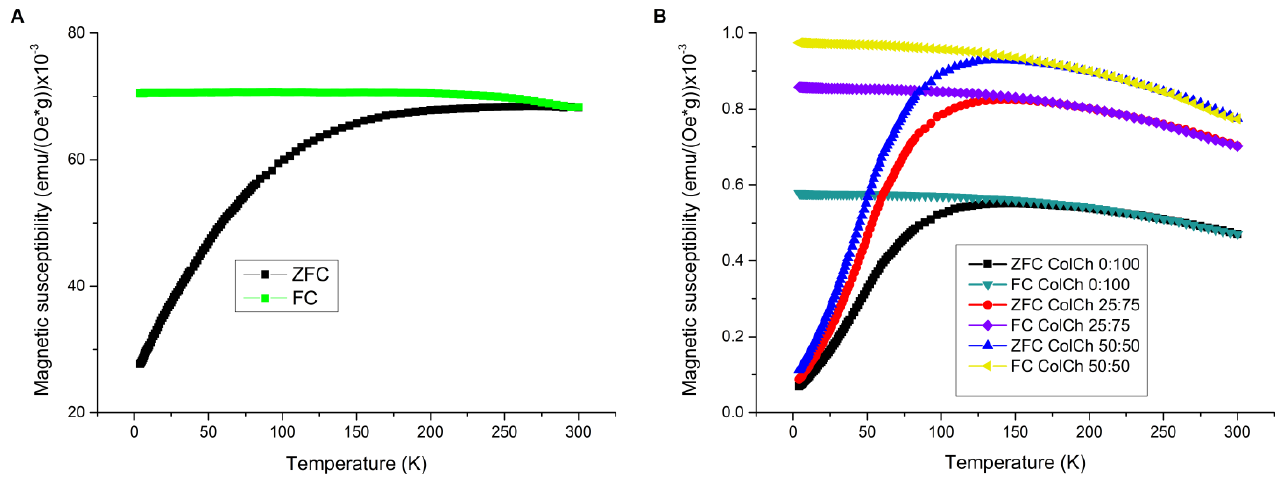
Figure 5. ZFC/FC curves measured for SPIONs ( A ) and hybrids ( B ). When comparing the obtained values of magnetic susceptibility for SPIONs and hybrids, a difference of two orders of magnitude could be observed. This was in line with the above discussed concentration issues and the resultant interparticle distance and interactions. The same tendency regarding the magnetic susceptibility of hybrid materials was noticed, as in the case of saturation magnetization. Here, small differences between materials in χ value also were observed, and as in Ms, they were rising with collagen content, which confirmed the effect of the matrix